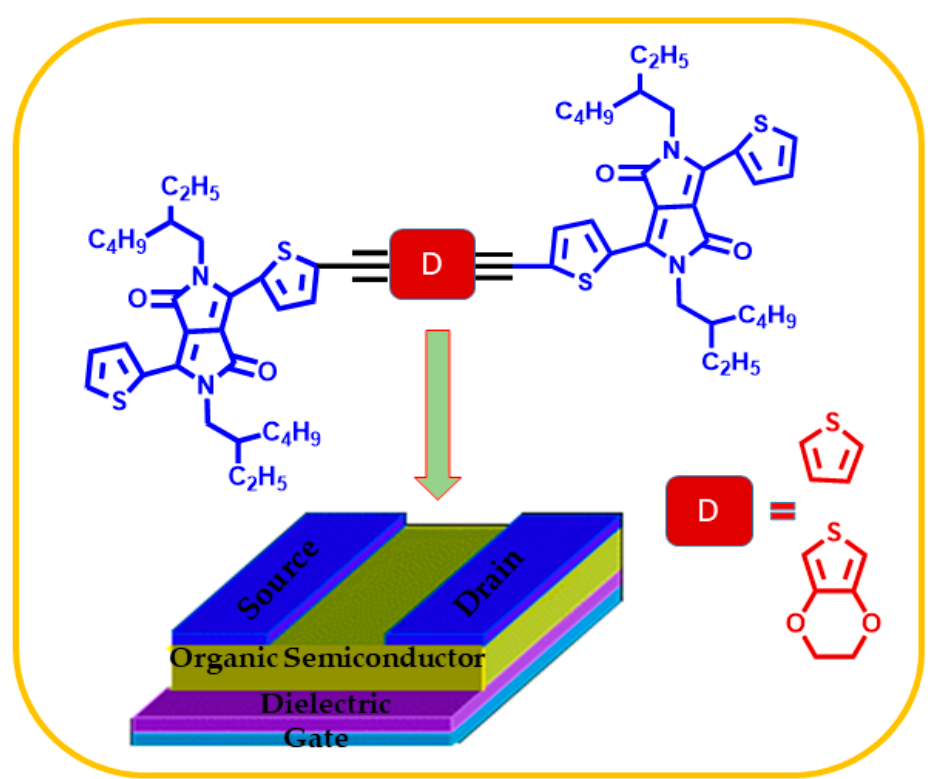
Scheme 1. Schematic representation of A- π -D- π -A type conjugated small molecules, TDPP-T and TDPP-EDOT, for OTFTs.